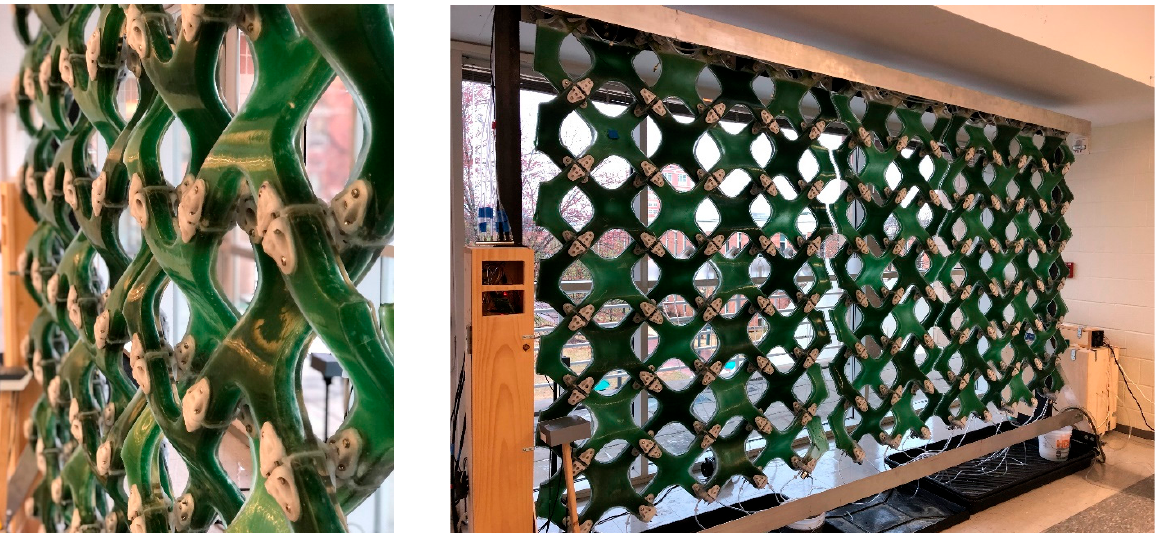
Figure 1. The microalgae facade in the creativity study is composed of a network of interlocking bioreactors filled with spirulina, blue-green microalgae.